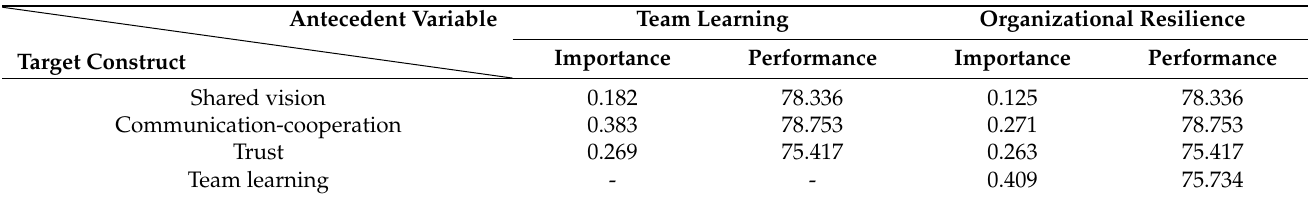
Table 3. Importance and performance of each antecedent